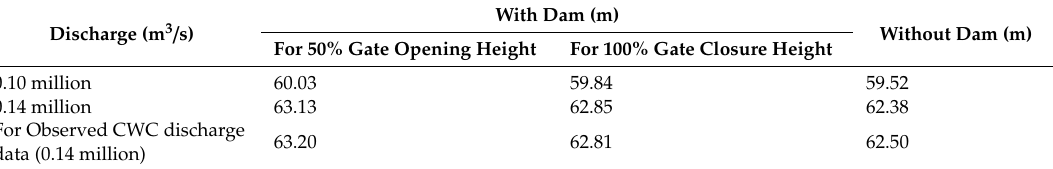
Figure 10. Water surface elevation for 1000 and 10,000 years discharge (considering discharge data at Dowleswaram and corresponding water levels at Polavaram) from Polavaram to Dummugudem. Table 8. Water surface levels at Bhadrachalam with and without dam for di ff erent discharges under 2D unsteady state